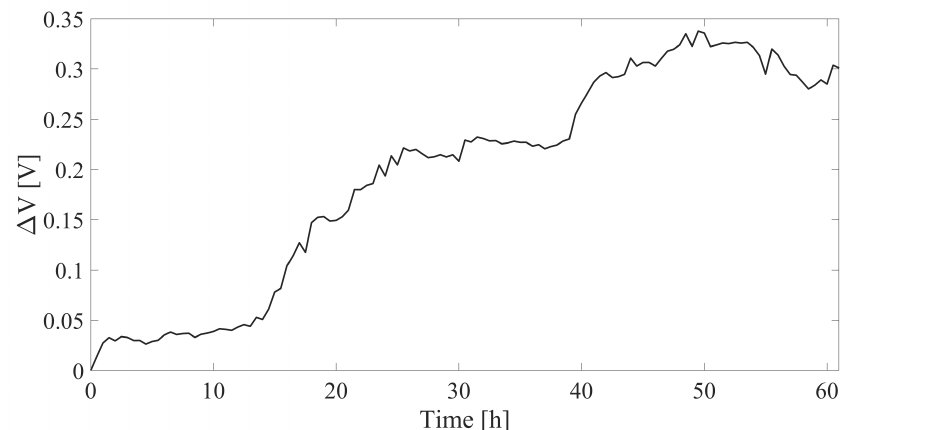
Figure 10. T- and RH-compensated output of the growth sensor plotted against time during the experimental trial.